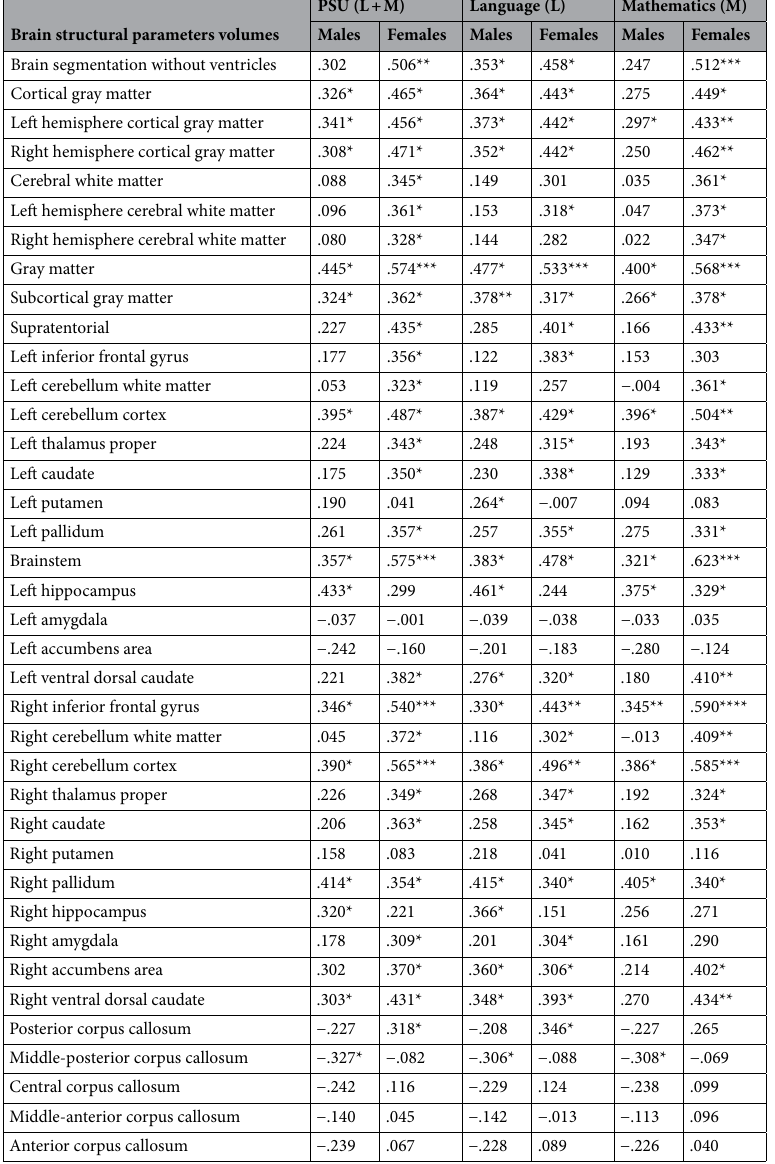
Table 4. Pearson correlation coefficients between brain structural parameters volumes and the University Selection Test outcomes by sex. PSU: University Selection Test; FDR q < .05 *; q < .01**; q < .001